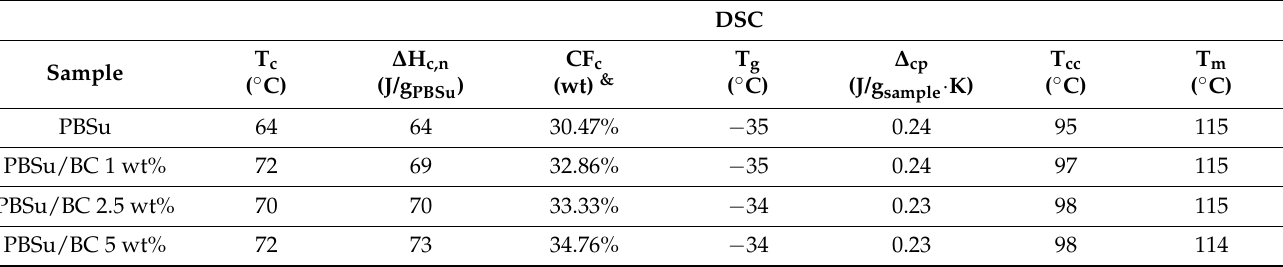
Table 2. Values of interest by